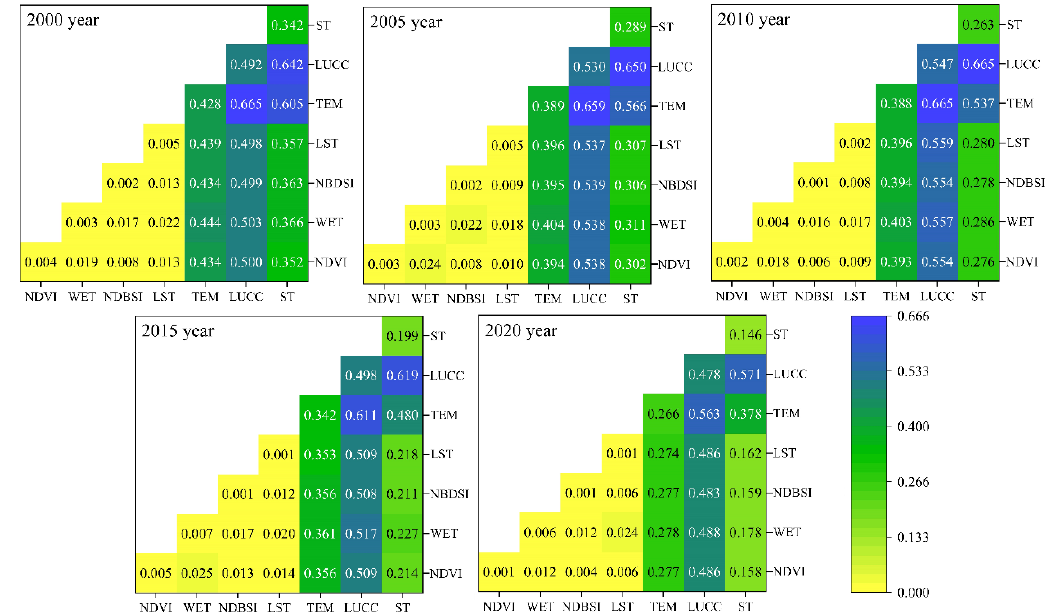
Figure 9. Interaction results between spatial heterogeneity factors.